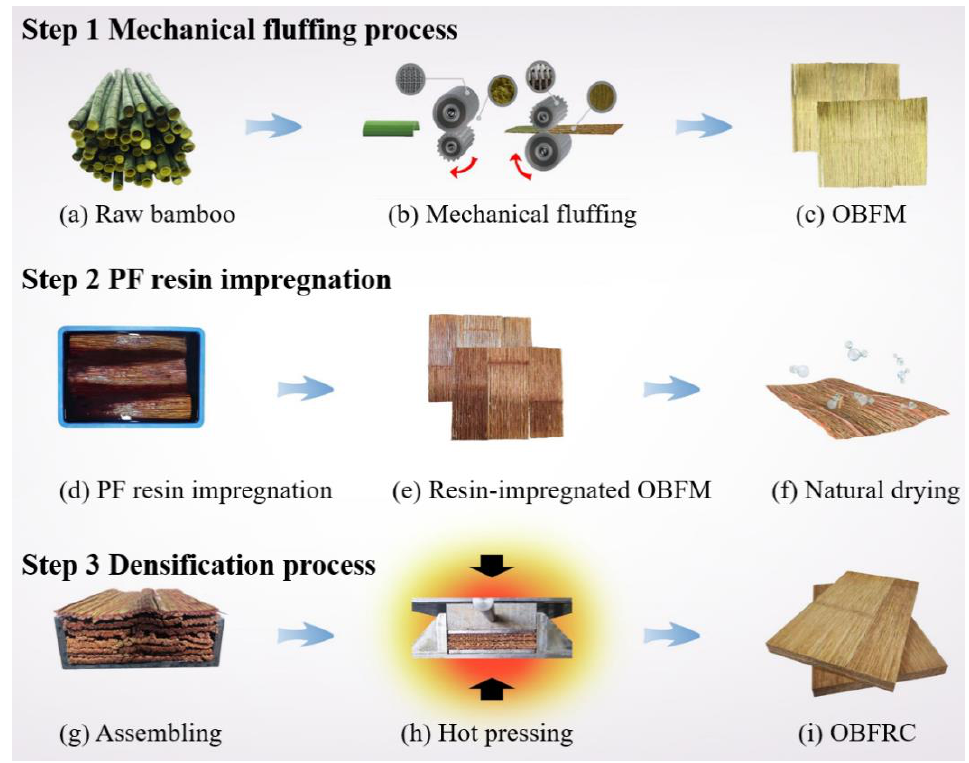
Figure 1. Three-step processing approach for creating outdoor bamboo-fiber-reinforced